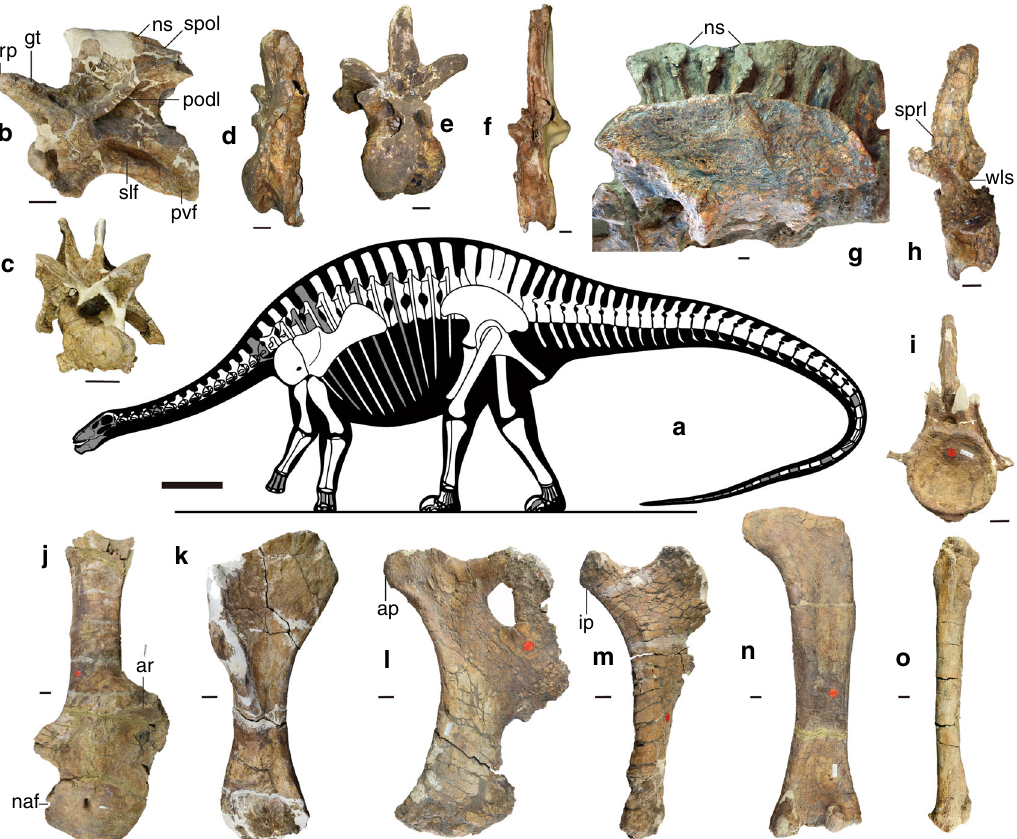
Fig. 2 Skeletal reconstruction and exemplar skeletal remains of Lingwulong shenqi . Silhouette showing preserved elements ( a ); middle cervical vertebra in left lateral ( b ) and anterior ( c ) views; anterior dorsal vertebra in left lateral ( d ) and anterior ( e ) views; posterior dorsal vertebra in lateral view ( f ); sacrum and ilium in left lateral view ( g ); anterior caudal vertebra in left lateral ( h ) and anterior ( i ) views; right scapulocoracoid in lateral view ( j ); right humerus in anterior view ( k ); left pubis in lateral view ( l ); right ischium in lateral ( m ) views; right femur in posterior view ( n ); and right tibia in lateral view ( o